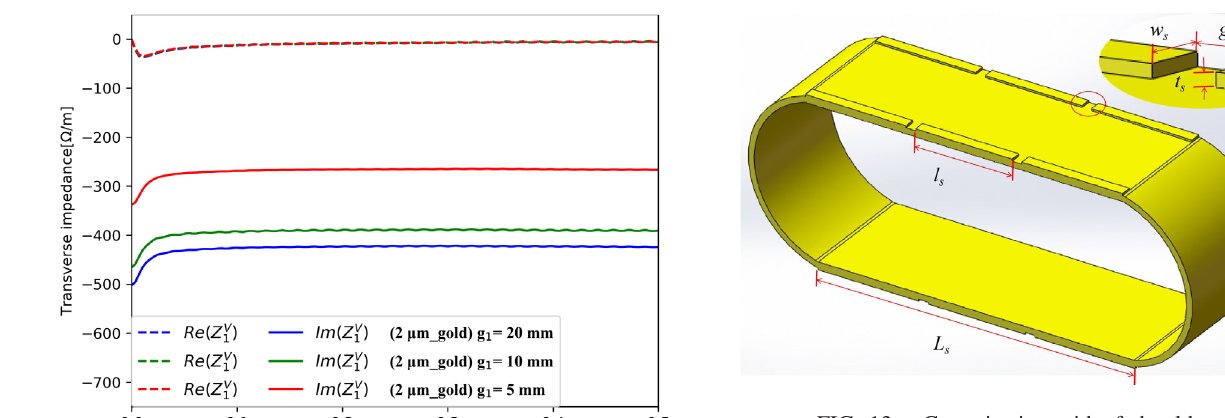
FIG. 13. Ceramic ring with rf